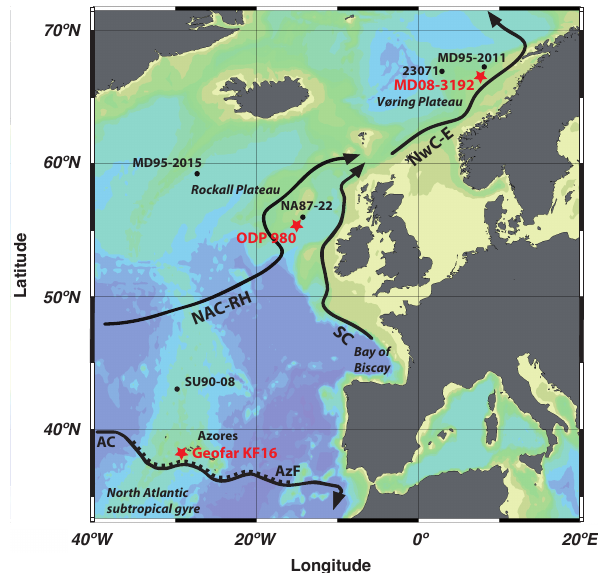
Fig. 1. Core position and main oceanographic features. Red stars mark the location of the studied sediment cores; black dots mark the position of other locations providing data for calculations of the carbonate system or coccolith counts discussed in the text. Black arrows show major ocean surface currents: North Atlantic Cur- rent Rockall–Hatton branch (NAC-RH), Slope Current (SC), east- ern branch of the Norwegian Current (NwC-E), and Azores Current (AC), with the corresponding Azores Front (AzF) figured as a black dashed line. The map was designed with the ODV software by